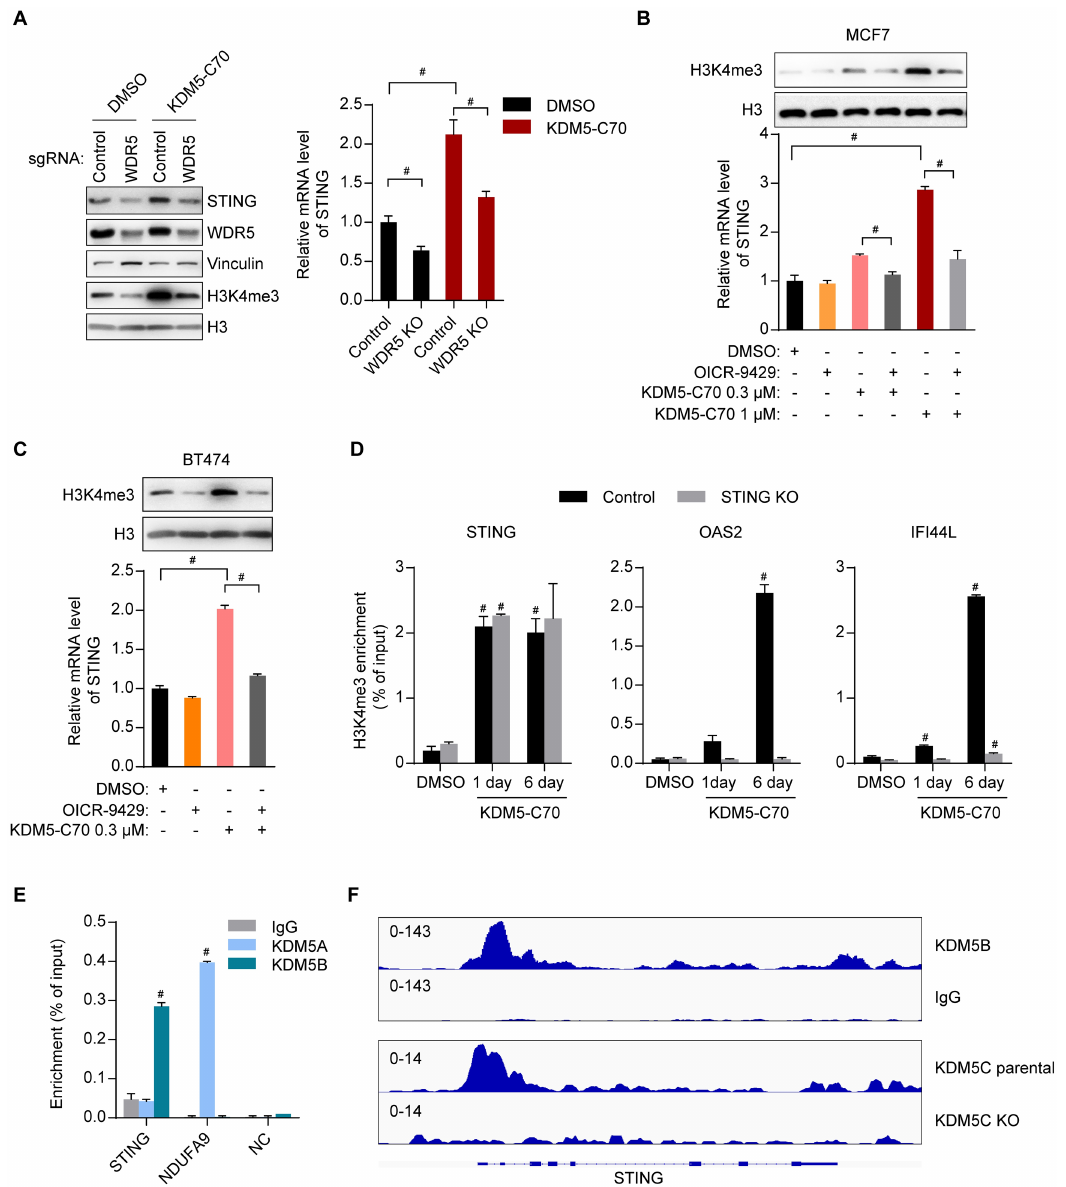
Fig 5. KDM5B and KDM5C bind to the promoter of STING and directly suppress STING expression. (A) Western blot (left panel) and RT-qPCR (right panel) analyses of STING in MCF7 cells with knockout of the indicated genes after treatment with DMSO or 1 μM KDM5-C70 for 3 days. (B, C) Western blot analysis of H3K4me3 (upper panel) and RT-qPCR analysis of STING (lower panel) in MCF7 cells (panel B) or in BT474 cells (panel C) after treatment with the indicated compounds for 3 days. The concentration of OICR-9429 was 20 μM. (D) H3K4me3 ChIP-qPCR analysis at the promoter of STING , OAS2 , or IFI44L in control or STING knockout MCF7 cells treated with DMSO or 1 μM KDM5-C70 for 1 day or 6 days. (E) KDM5A and KDM5B ChIP-qPCR analysis of MCF7 cells at the STING and NDUFA9 promoters, or downstream of the last STING exon as NC. (F) Analysis of ChIP-seq data for KDM5B binding at the STING genomic region in K562 cells (GSE29611, upper panel) and KDM5C in ZR-75-30 cells (GSE71327, lower panel) [42]. Representative data from triplicate experiments are shown. Error bar denotes SEM. # p < 0.01 for the comparisons shown in panel A–C, for inhibitors versus DMSO (panel D), and for KDM5A or KDM5B ChIP versus IgG ChIP (panel E). The numerical values used to generate graphs in panel A–E are available in S1 Data. ChIP, chromatin immunoprecipitation; ChIP-seq, chromatin immunoprecipitation sequencing; IgG, immunoglobulin G; NC, negative control; RT-qPCR, RT-qPCR, reverse transcription followed by quantitative PCR; STING, stimulator of interferon